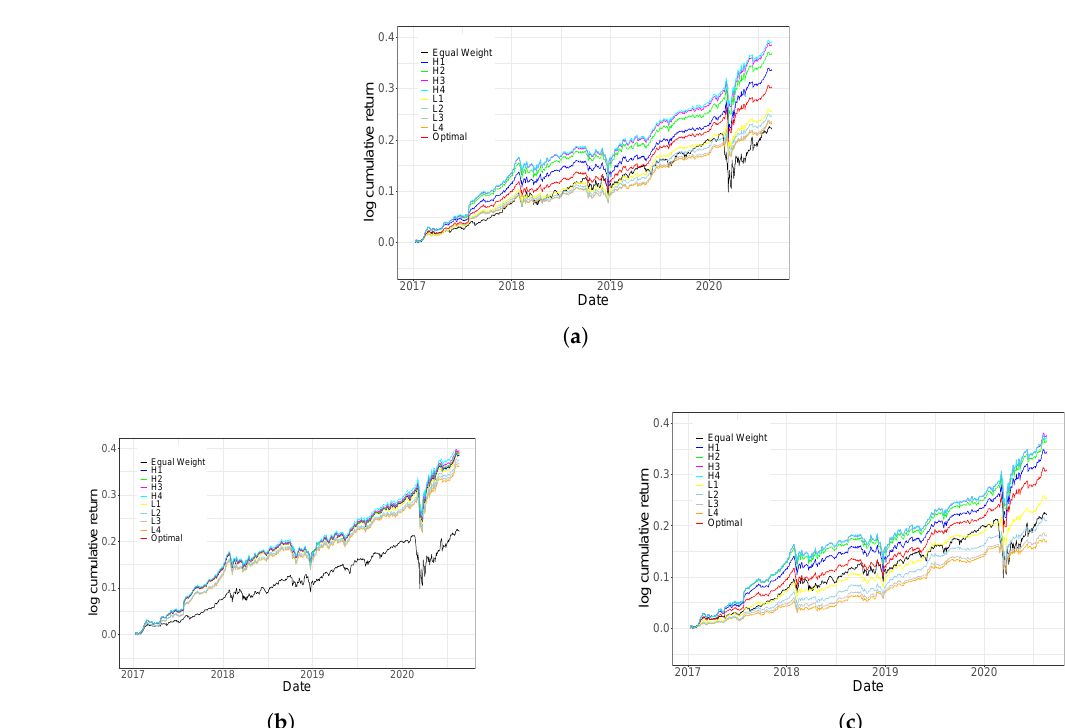
Figure 5. Time series of log cumulative return of suboptimal portfolios with different risk measures. ( a ) 0-CDaR Suboptimal portfolios: this figure plots the paths of 0-CDaR suboptimal portfolios from level H1 to L4, and the equally weighted portfolio. ( b ) 0.5-CVaR Suboptimal portfolios: this figure plots the paths of 0.5-CVaR suboptimal portfolios from level H1 to L4, and the equally weighted portfolio. ( c ) MV suboptimal portfolios: this figure plots the paths of mean variance suboptimal portfolios from level H1 to L4, and the equally weighted